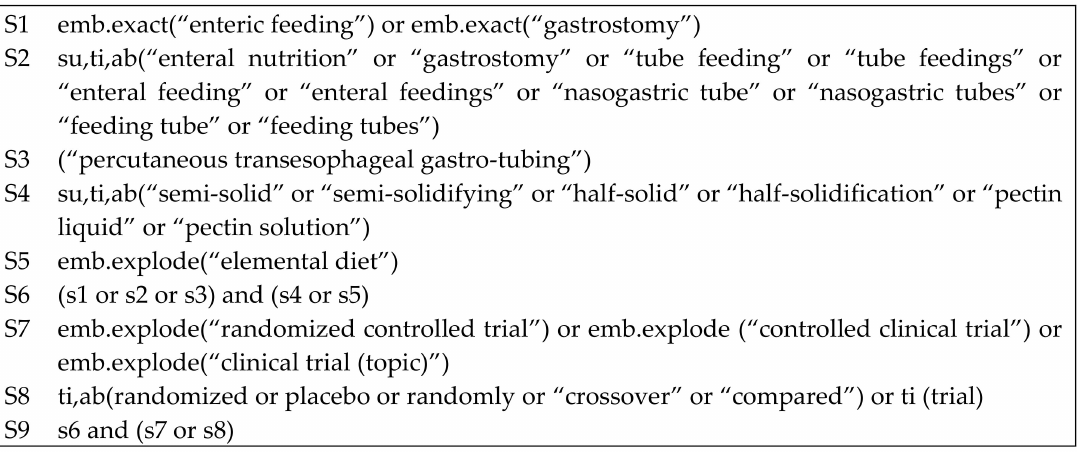
Figure A2. MEDLINE search strategy (PubMed).